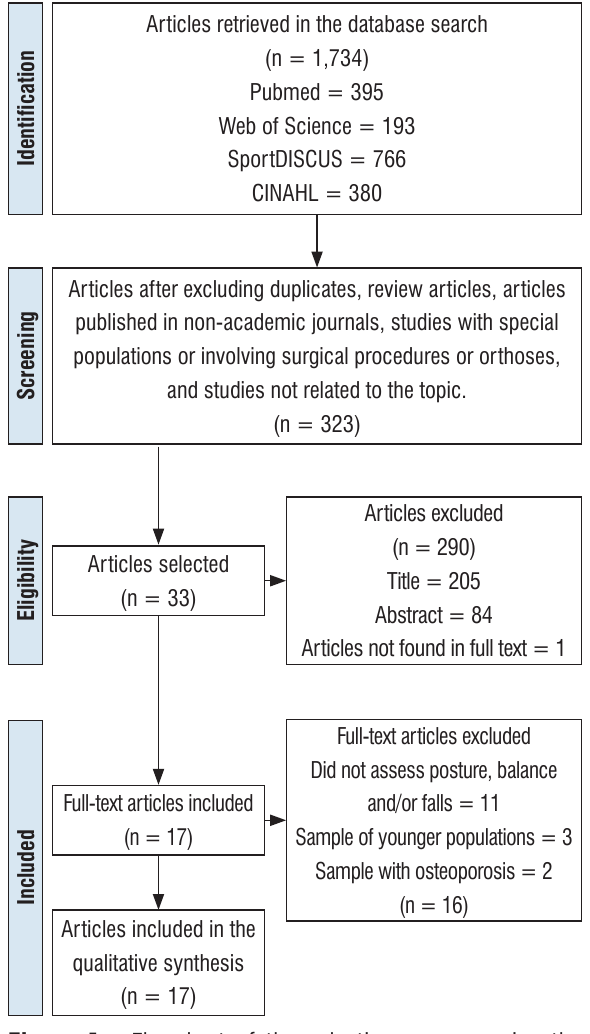
Figure 1 - Flowchart of the selection process using the PRISMA criteria [ 20 ]